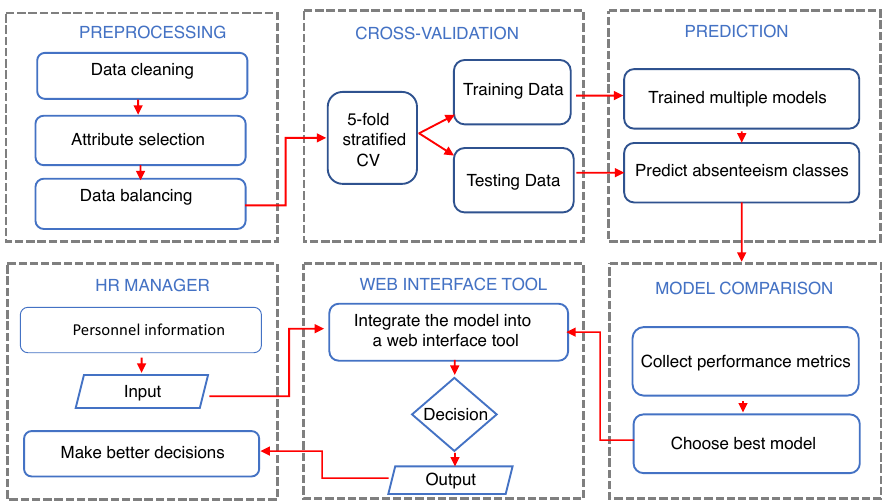
Figure 1. A flowchart outlining the proposed